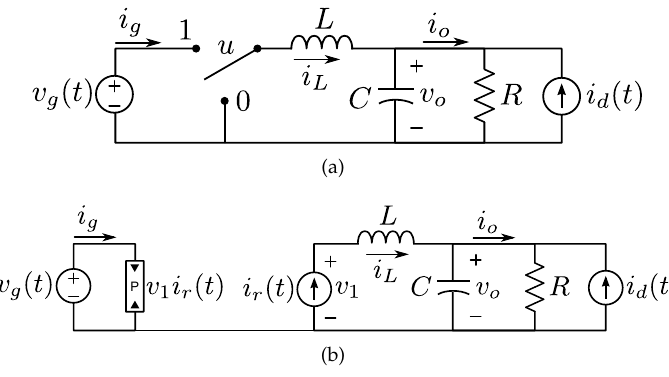
Figure 10. Schematic circuit diagram of ( a ) a Buck converter and ( b ) its ideal sliding-mode dynamics model under